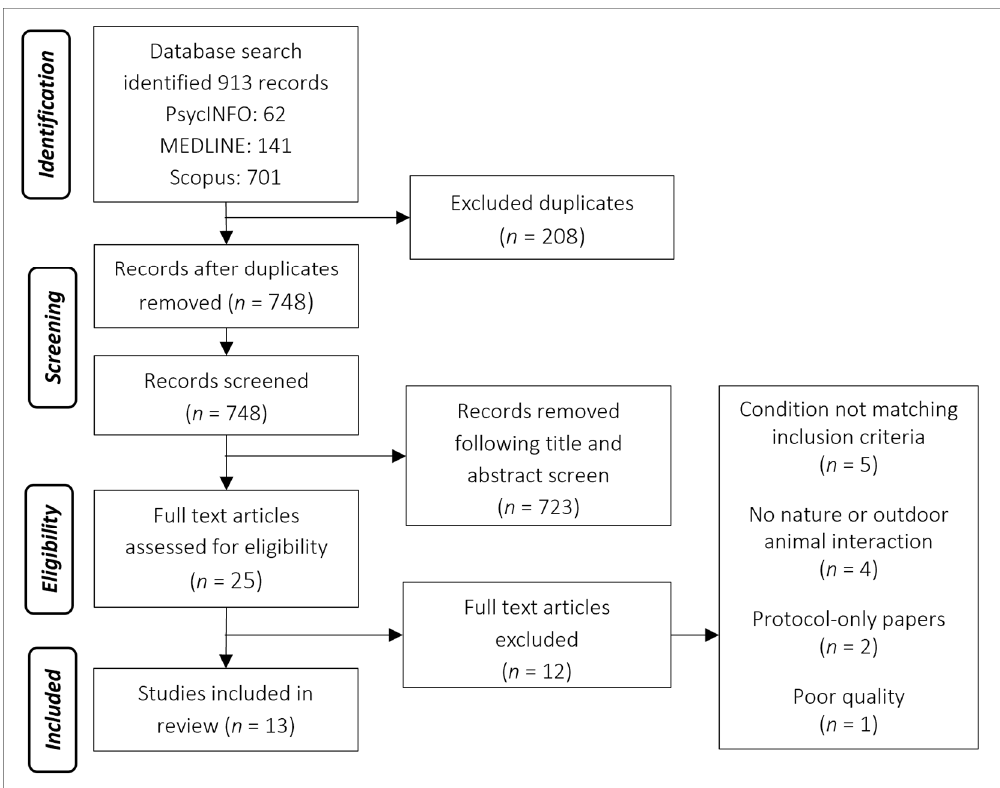
Figure 1. PRISMA flow diagram depicting the process of screening.